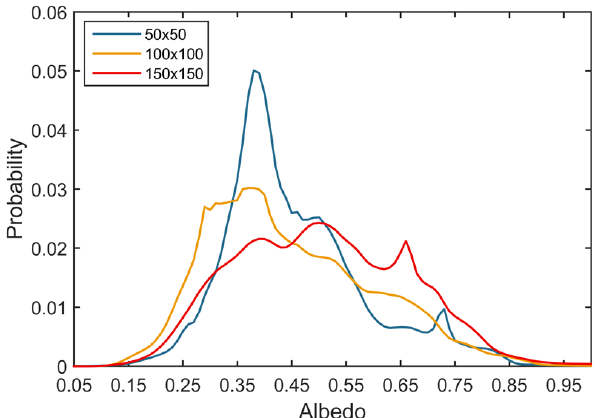
Figure 11. MODIS 2012 seasonal average for the 100 × 100 spatial extent. A region of dark ice, known as the “dark band”, extends through our study area (< ∼ 0.35, shown in bright blue